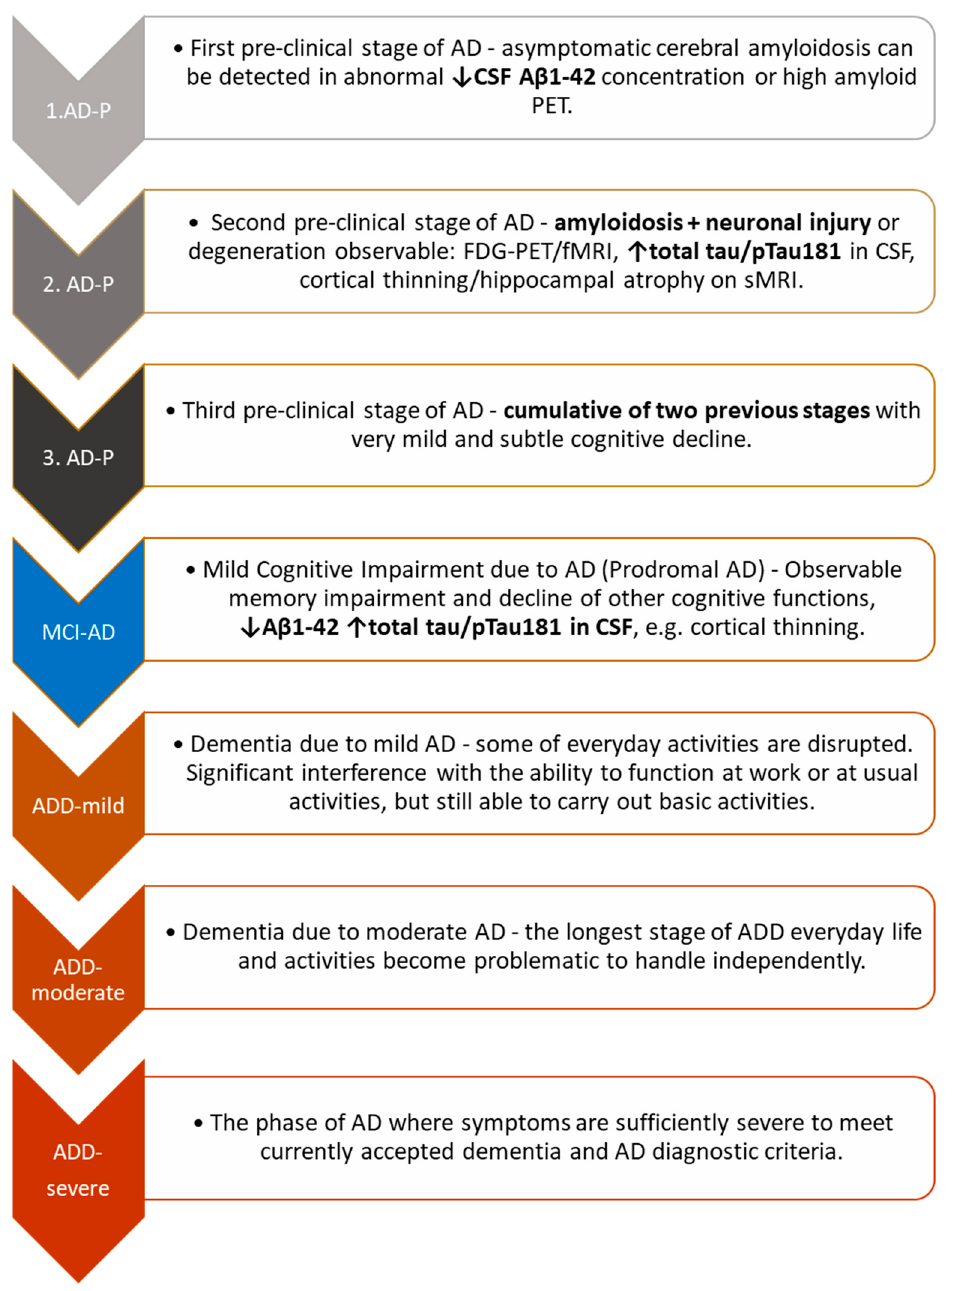
Figure 2. Alzheimer Disease continuum. Abbreviations: AD-P, preclinical stages of Alzheimer’s disease; AD, Alzheimer’s disease; MCI-AD, mild cognitive impairment due to Alzheimer’s disease; CSF, cerebrospinal fluid; FDG, fluorodeoxyglucose; PET, positron emission tomography.